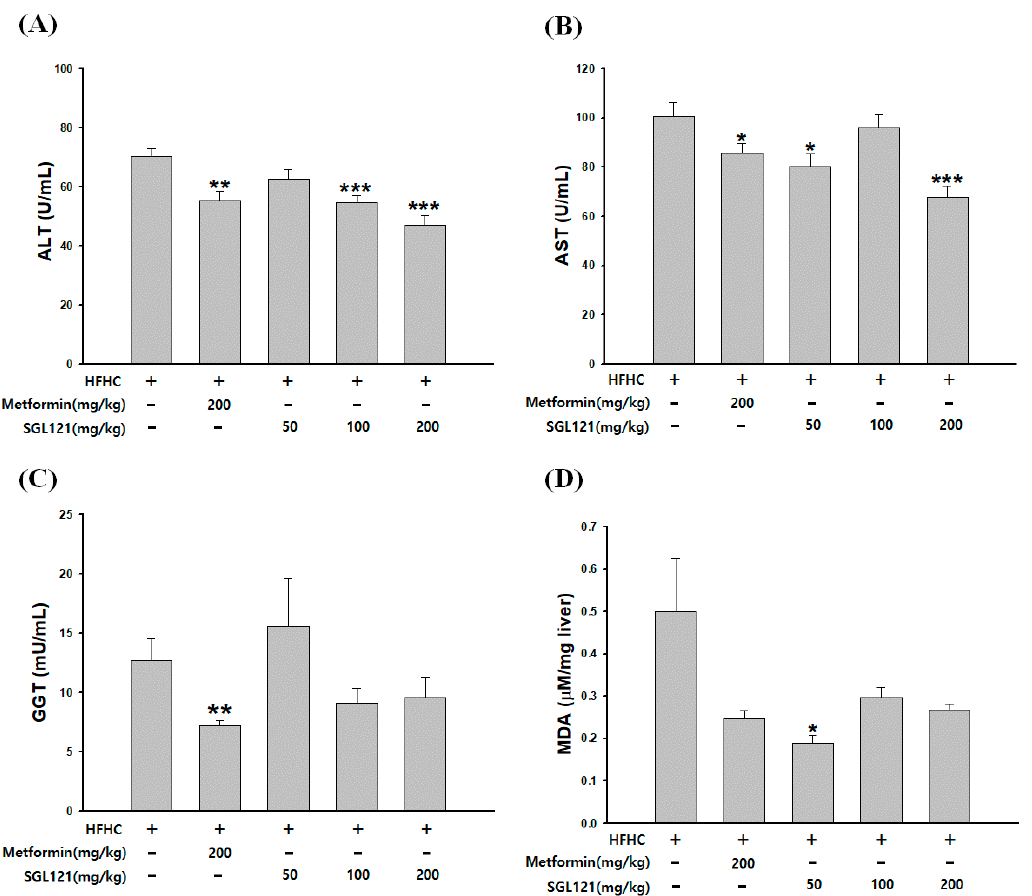
Figure 3. Effect of SGL 121 on liver function improvement in NAFLD-induced mice. ( A ) Serum aspartate aminotransferase (AST) activity, ( B ) serum AST activity, ( C ) serum γ -glutamyl transpeptidase (GGT) activity, and ( D ) malondialdehyde (MDA) level in liver. Data are presented as the mean ± SE, n = 8. * p < 0.05, ** p < 0.01, and *** p < 0.001 compared to the HFHC group.